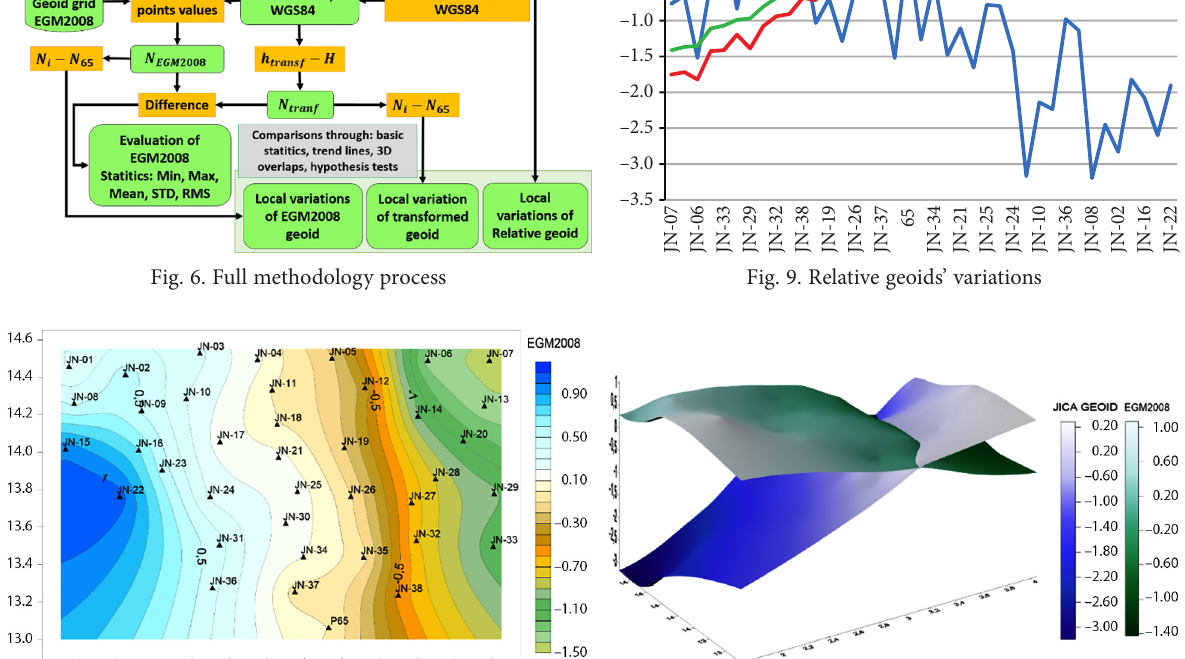
Fig. 10. 3D view of EGM2008 (green) and JICA-IGNN geometric (blue)